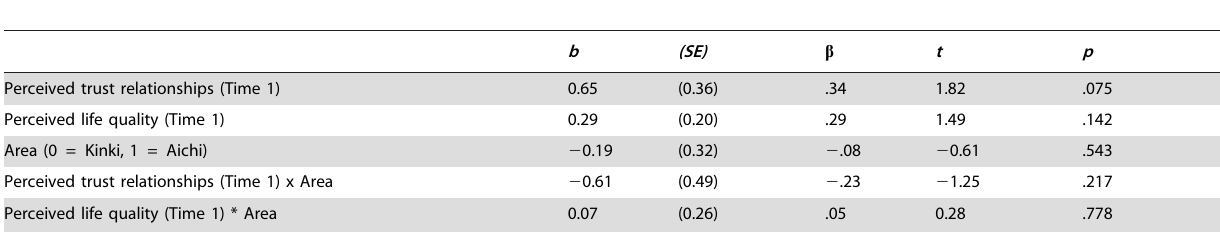
Table 5. Effects of trust relationships among community residents (Time 1), life quality of community residents (Time 1), area, and their interactions on life quality of community residents (Time 2), N =60.